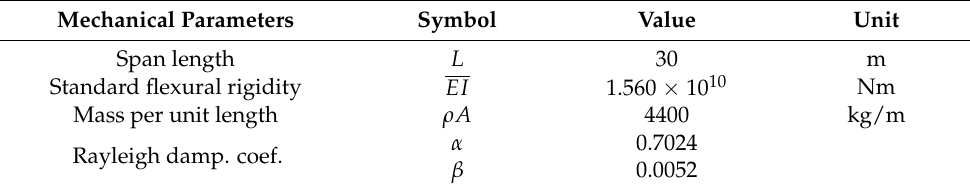
Table 2. The bridge parameters.